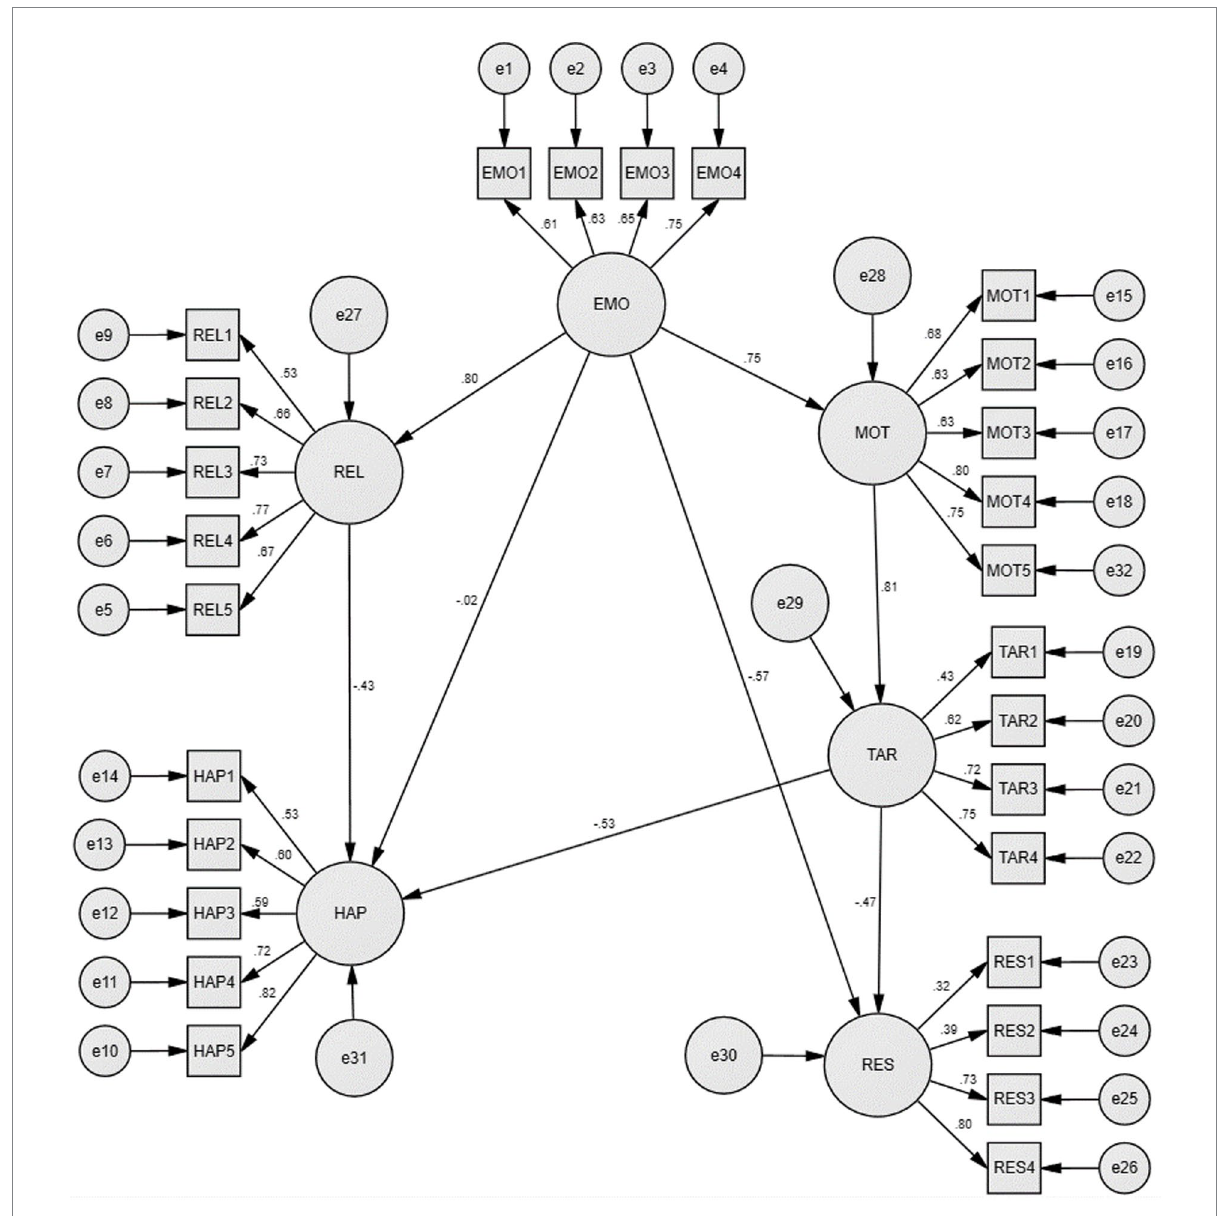
FIGURE 2 The initial structural equation model.